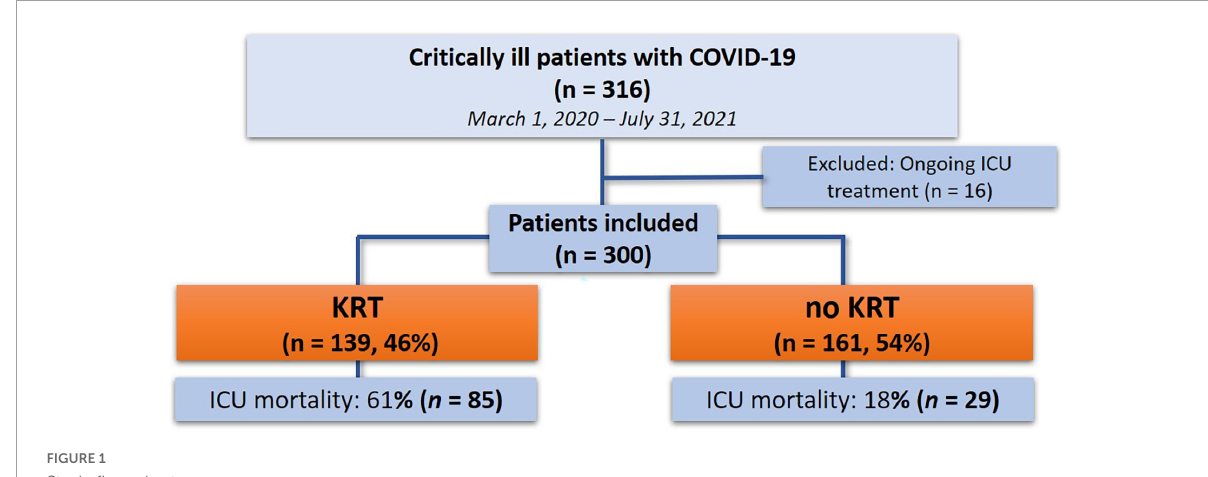
FIGURE1 Study flow chart.